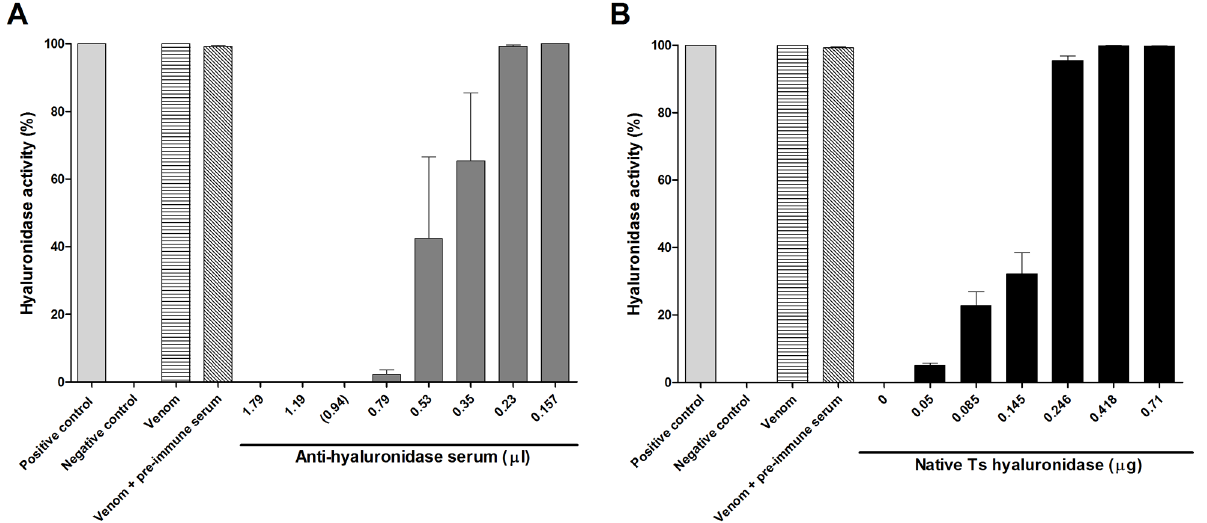
Figure 5. Invitro neutralization assays using rabbit anti-hyaluronidase serum. (A) Hyaluronidase activity (%) was measured using the turbidimetric assay. Tityus serrulatus venom (1 LD 50 , 13.2 m g) was incubated with different quantities of anti-hyaluronidase serum (0.157–1.79 m l) for 1 h at 37 u C. The minimum volume of anti-hyaluronidase serum needed to neutralize Tityus serrulatus venom was 0.94 m l (marked with parentheses). (B) Hyaluronidase activity (%) of Tityus serrulatus venom (13.2 m g) samples pre-incubated for 1 h at 37 u C with anti-hyaluronidase serum (0.94 m l), and subsequently added with increasing quantities of native Tityus serrulatus hyaluronidase (0–0.71 m g). Commercial hyaluronidase was used as the positive control. Ultra-pure water served as the negative control. Additional controls were Tityus serrulatus venom (13.2 m g) in the absence and presence of pre-immune serum (2 m l). All values are the mean 6 S.E.M. of duplicates from 3 independent experiments.